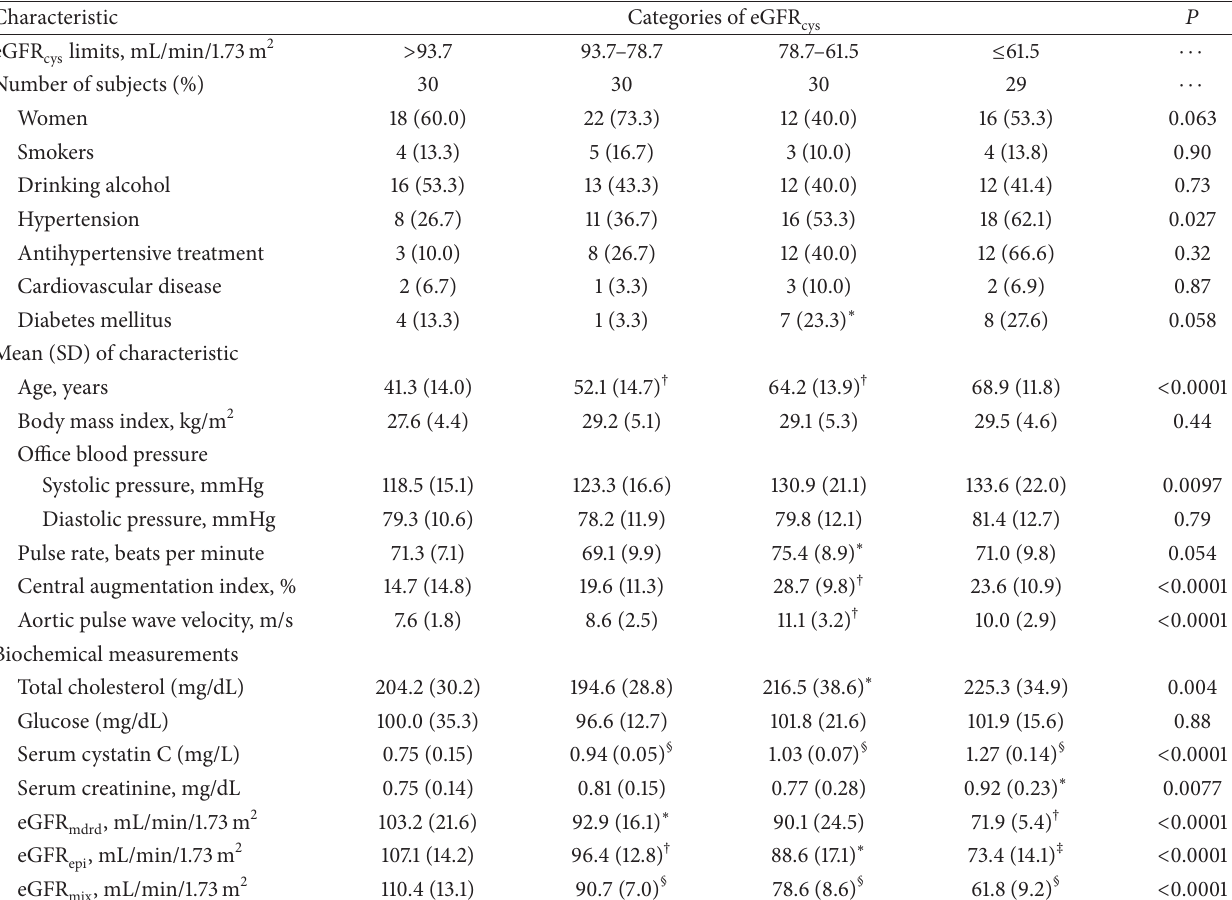
Table 1: Characteristics of 119 participants by fourths of the distribution of eGFR